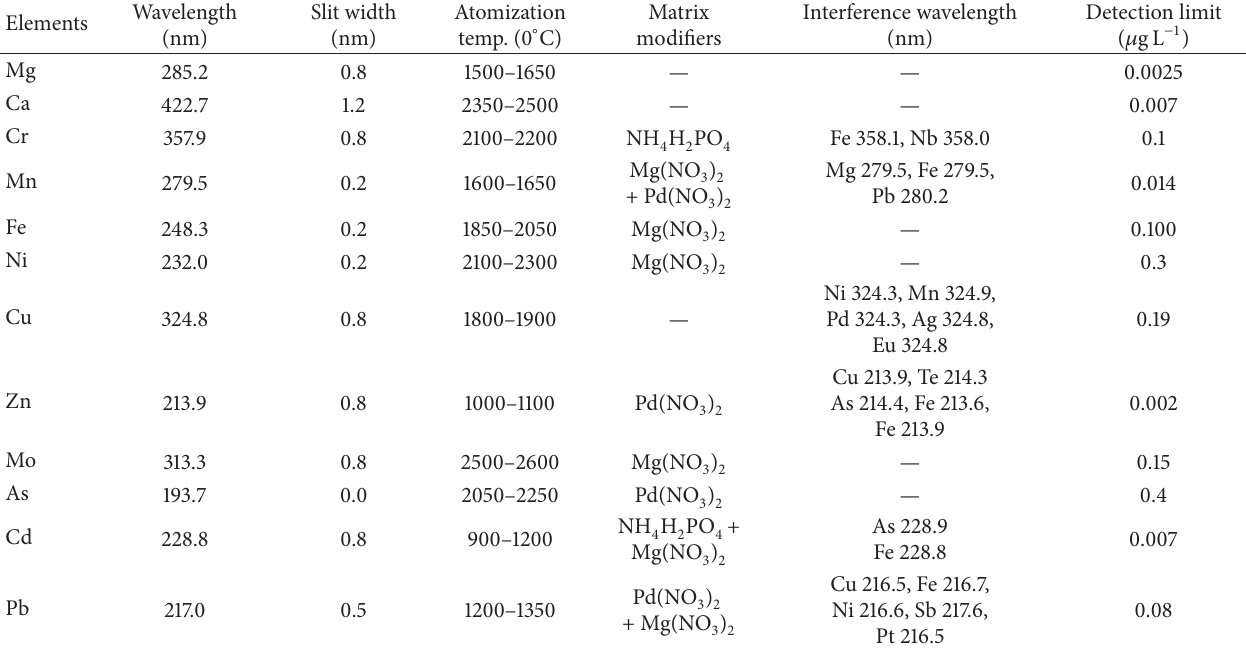
Table 1: AAS Vario-6 Graphite furnace elements instrumental analytical conditions. Elements